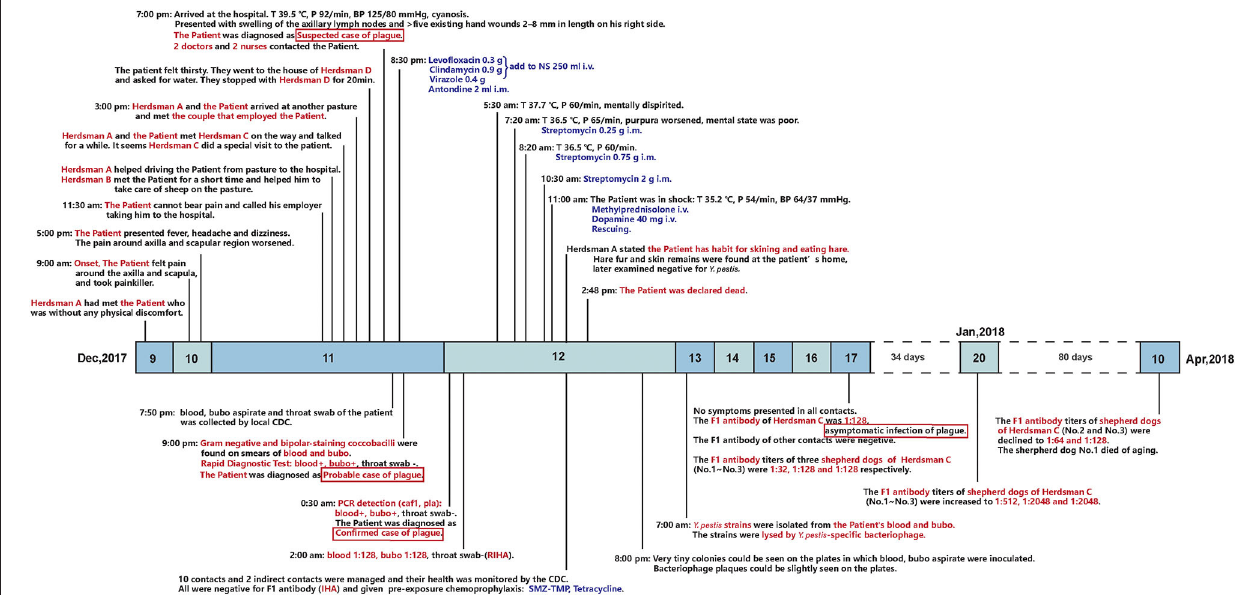
FIGURE 1 | Timeline of the outbreak and follow-up on shepherd dogs. Above the timeline: epidemiological history and clinical presentations of the patient. Below the timeline: laboratory tests of the patient and the contacts, post-exposure prophylaxis of the contacts, and follow-up on the anti-F1 antibody titer of the three shepherd